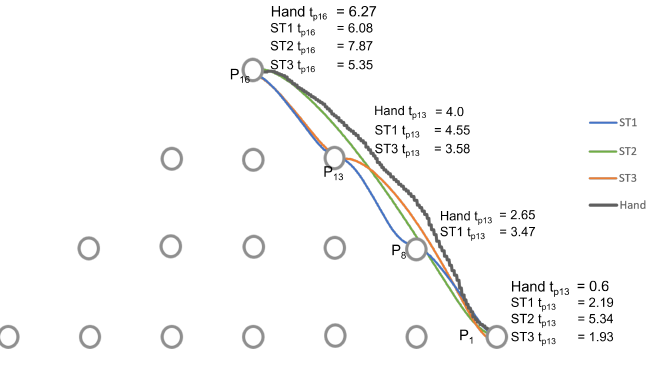
Figure 10. A representation of the actual hand motion and the resultant robot motion projected on the y-z plane. The time the robot stops at a point is indicated for each strategy, as well as the time the hand is closest to each point. For p 1 , the time at which the motion starts is indicated. For p 8 , p 13 , and p 16 , the time the robot stops is indicated. For p 16 , the time the hand stops is indicated. For p 8 and p 13 , the hand that is the closest is